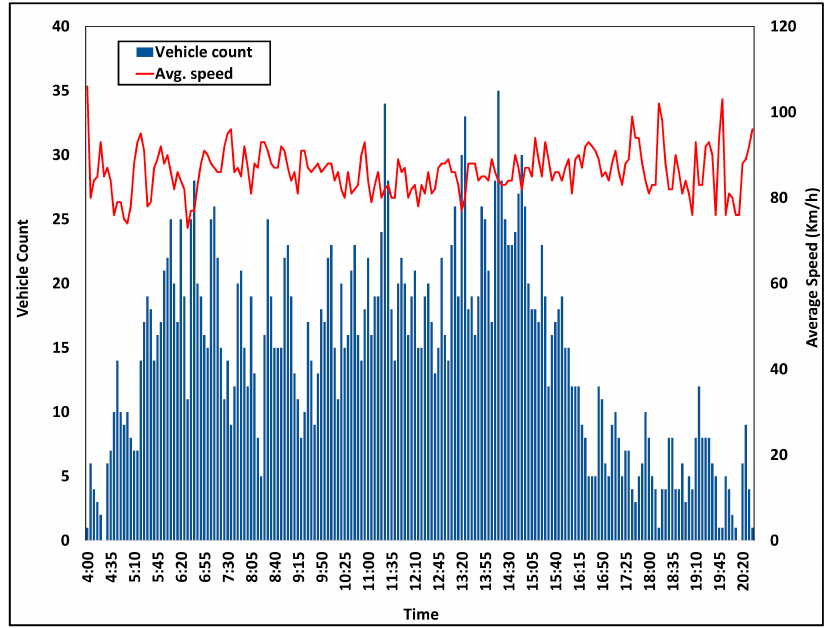
Figure 5. Vehicular density analysis of Aarhus City, Denmark.